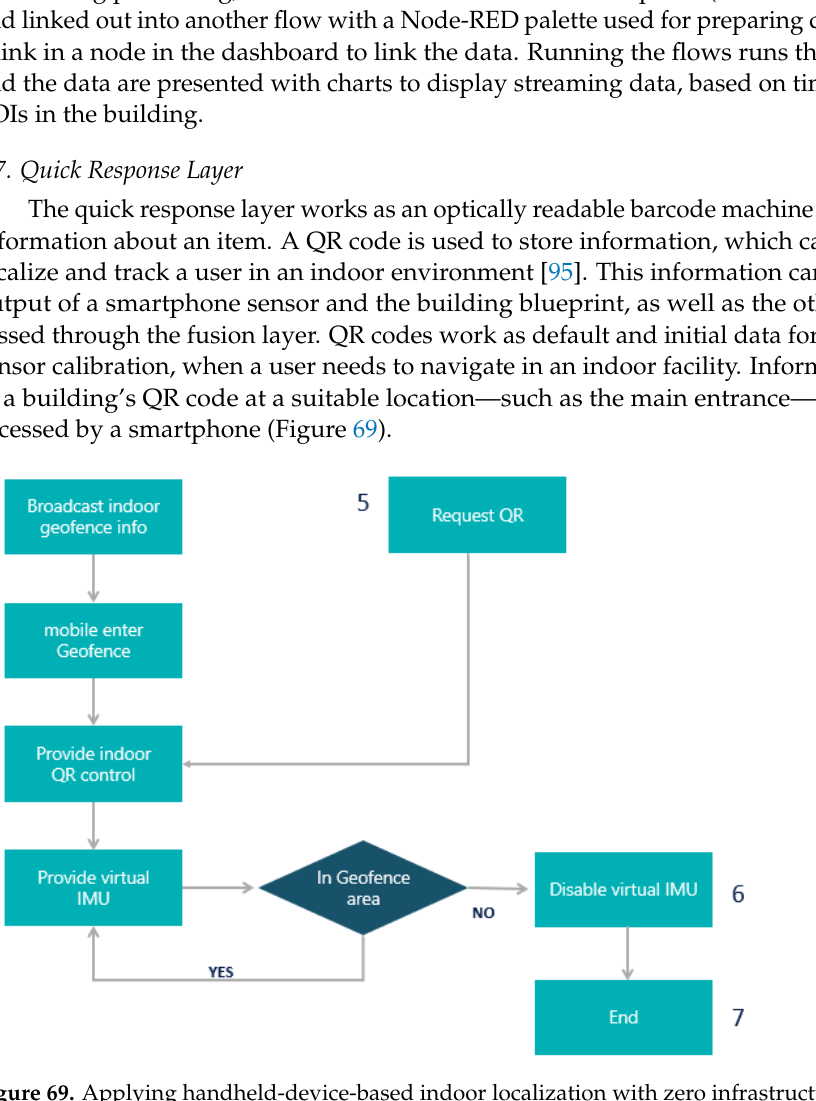
Figure 69. Applying handheld-device-based indoor localization with zero infrastructure.